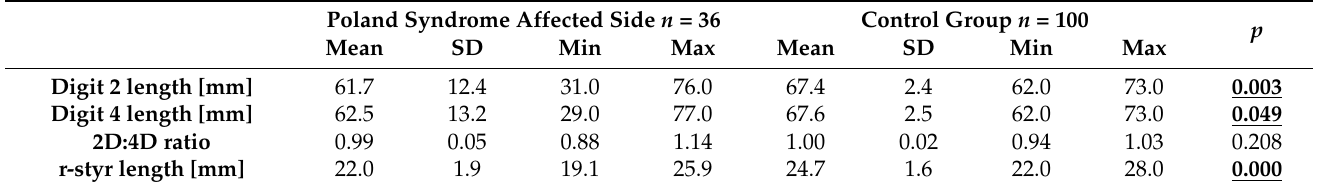
Table 2. Comparison of hand parameters between affected side of patients with Poland anomaly and control